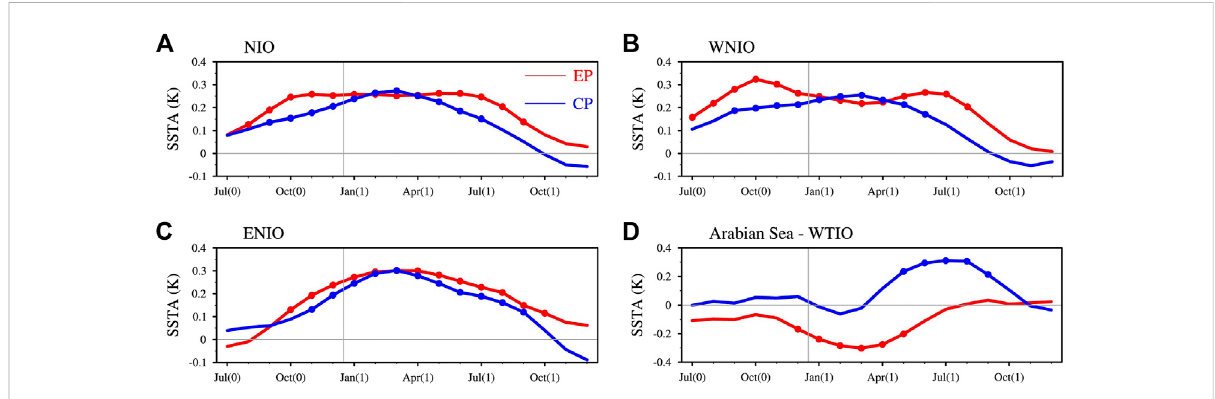
FIGURE 7 Monthlyevolutionoftheseasurfacetemperatureanomaly(SSTA;units:K)over (A) thenorthernIndianOcean(NIO;0 – 20 ° N,50 – 100 ° E), (B) the westernNIO(WNIO,0 – 20 ° N,50 – 80 ° E), (C) theeasternNIO(ENIO,0 – 20 ° N,80 – 100 ° E)duringEPElNiño(blue)andCPElNiño(red)events.Thetime axis is from July of the El Niño developing year (0) to December of the following year (+1). Markers indicate signals statistically signi fi cant at the 90% con fi dence level. (D) Monthly evolution of the differences in the SSTA (units: K) between the Arabian Sea (15 – 25 ° N, 55 – 75 ° E) and the western TIO (WTIO, 10 ° S – 10 ° N, 40 – 60 °